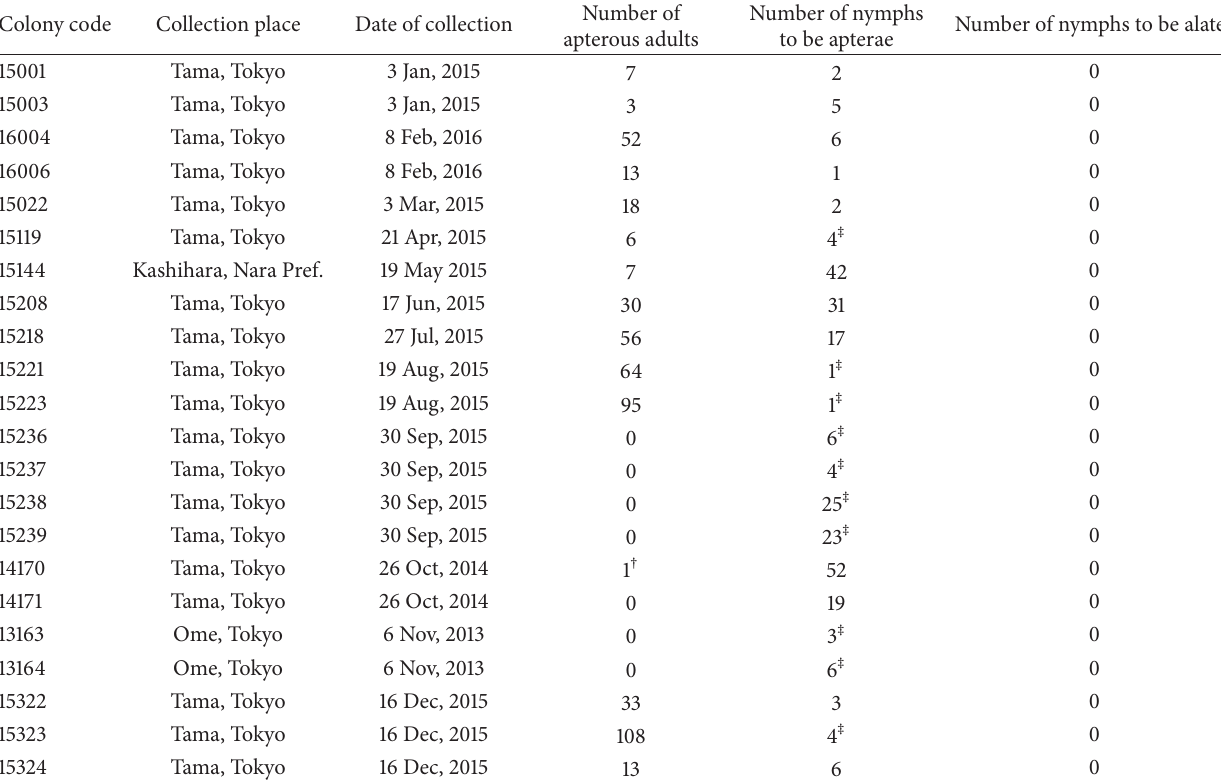
Table 2: Collection data, the number of apterous adults and those of nymphs for 22 ordinary colonies. Colony